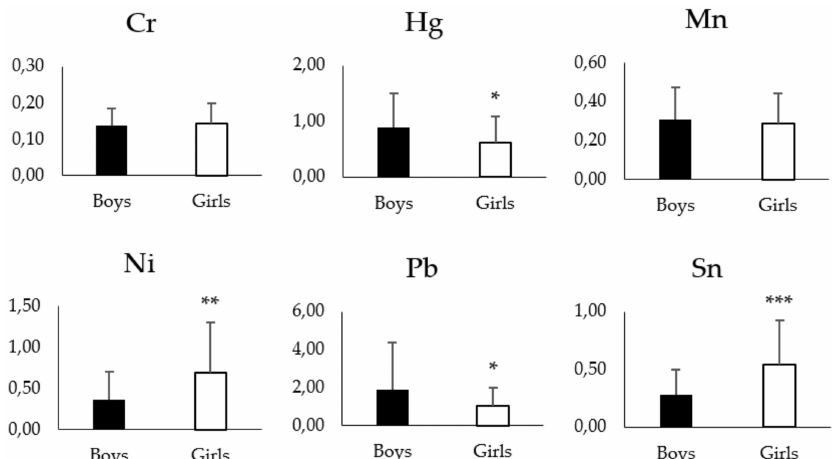
Figure 2. Metal concentrations ( µ g / g) in hair of schoolboys ( n = 44) and girls ( n = 50) living in Tarragona County (2017). Data are given as mean ± SD. Statistics: non-parametric t-test. Significant di ff erences between both groups at: * p < 0.05, ** p < 0.01 and *** p < 0.001.